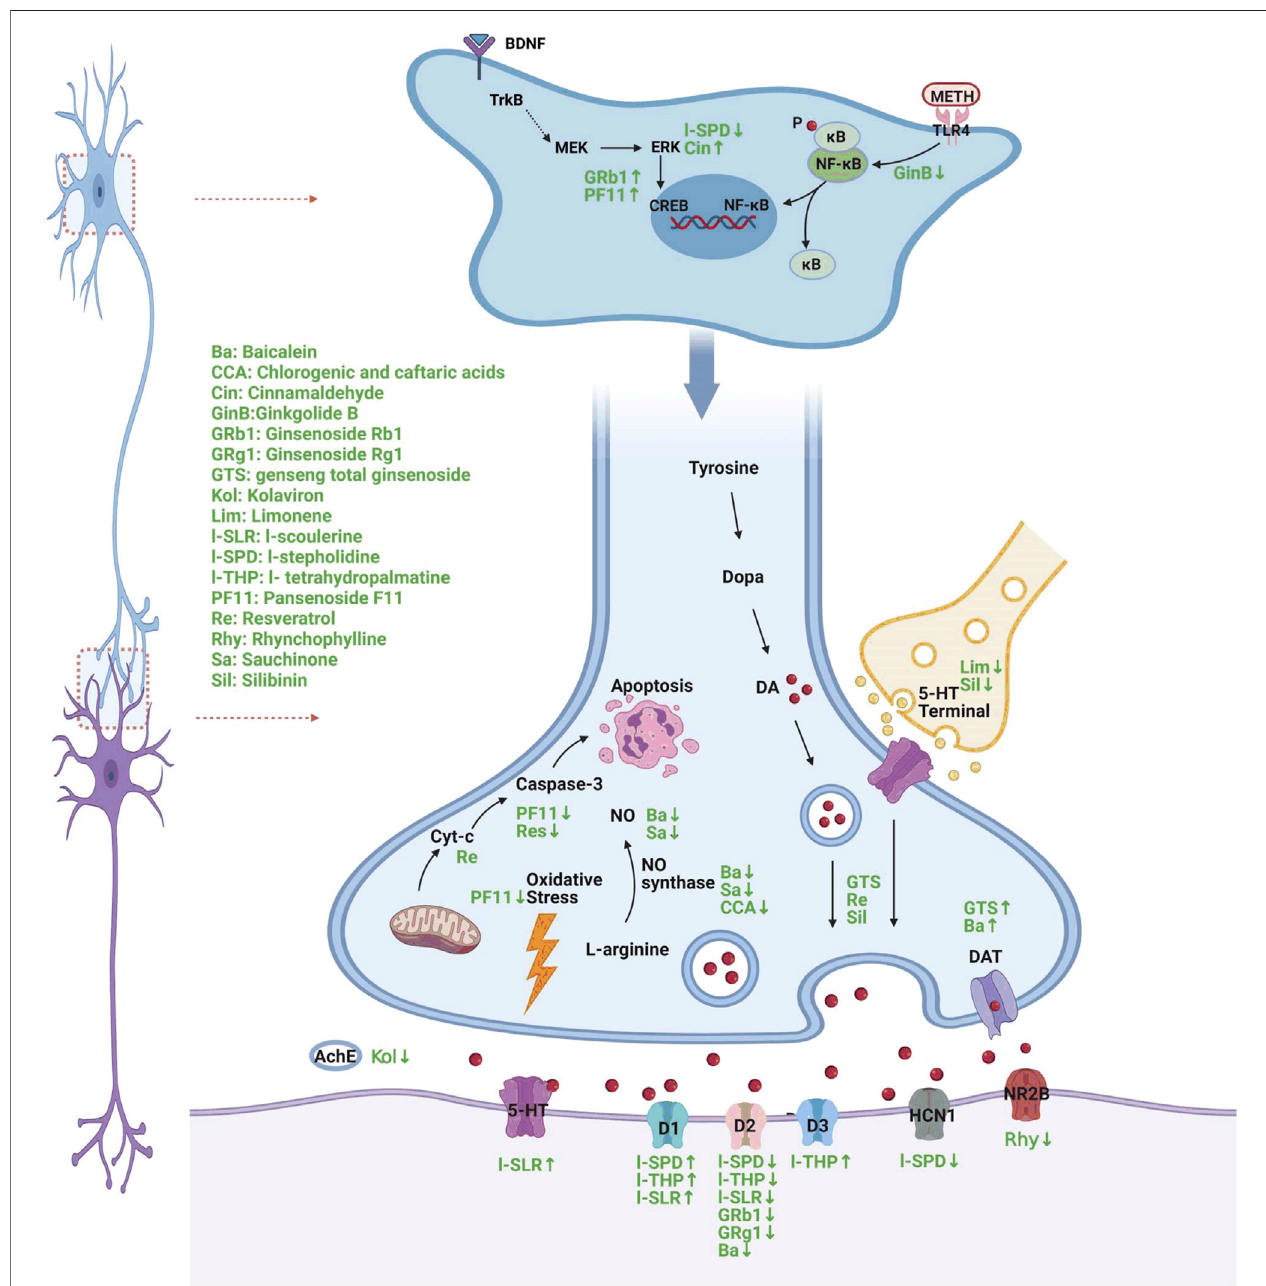
FIGURE 1 | A diagram of the mechanism of different Chinese herbs in the treatment of METH-induced neuropsychiatric injury (Created with BioRender.com). ® ↓ symbol indicates decrease and ↑ symbol indicates increase following METH treatment.